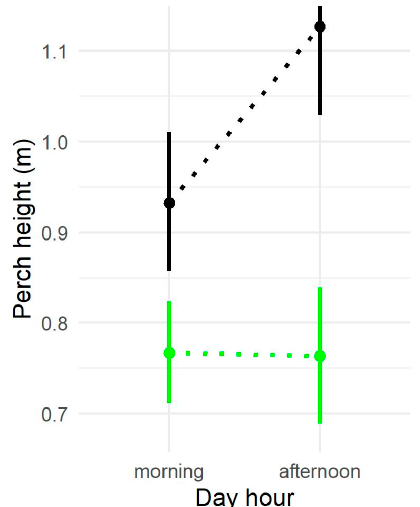
Figure 4. Perch height in suburban (black) and forest (green) populations of Anolis homolechis . Sampled sites are referred to as Site 1: Guanajay, Site 2: San José de Las Lajas, Site 3: Sierra del Rosario, and Site 4: Escaleras de Jaruco. Vertical bars indicate 95% confidence intervals.